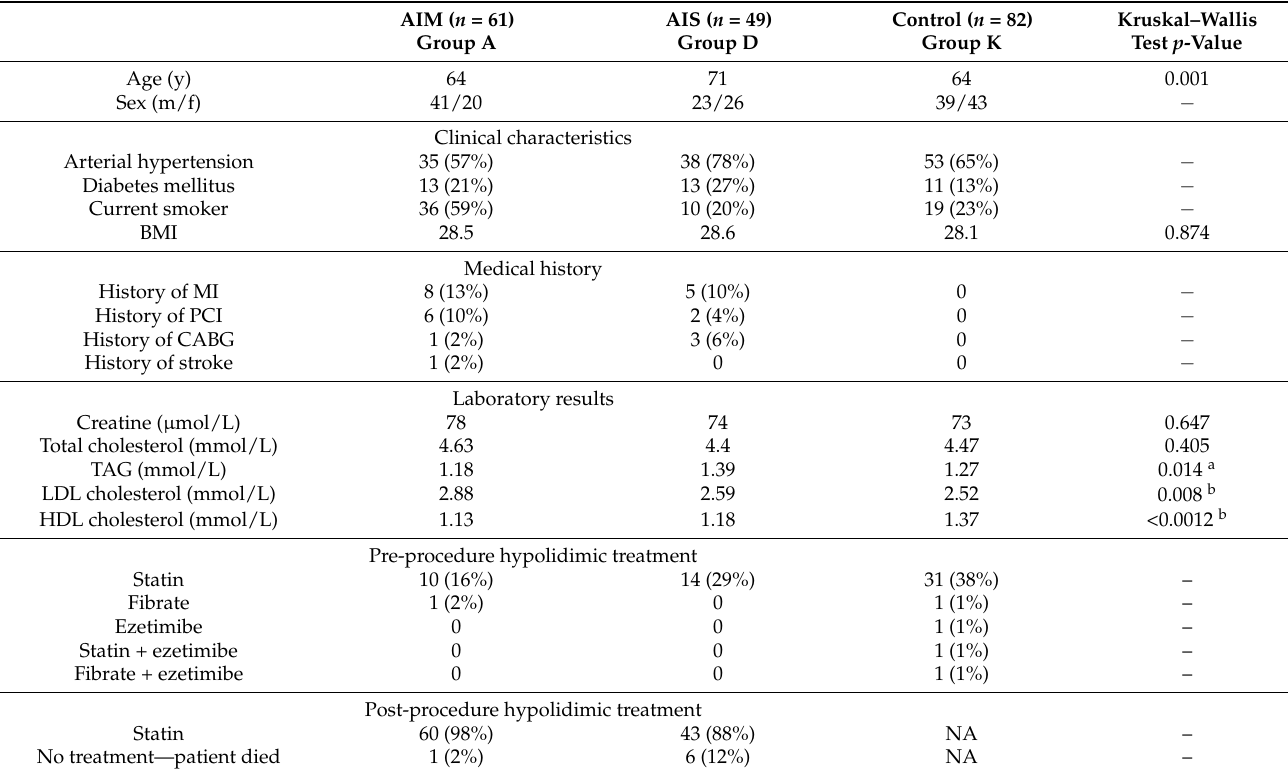
Table 5. Patient